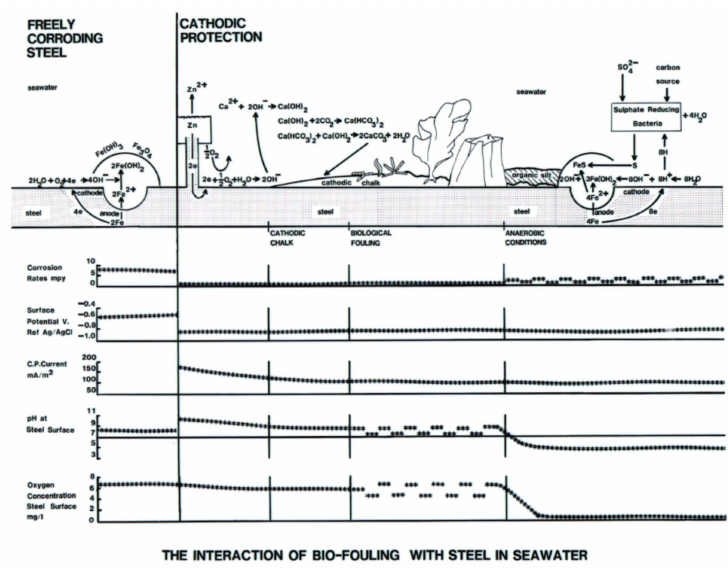
Figure 1. Interaction of biofouling with steel in seawater